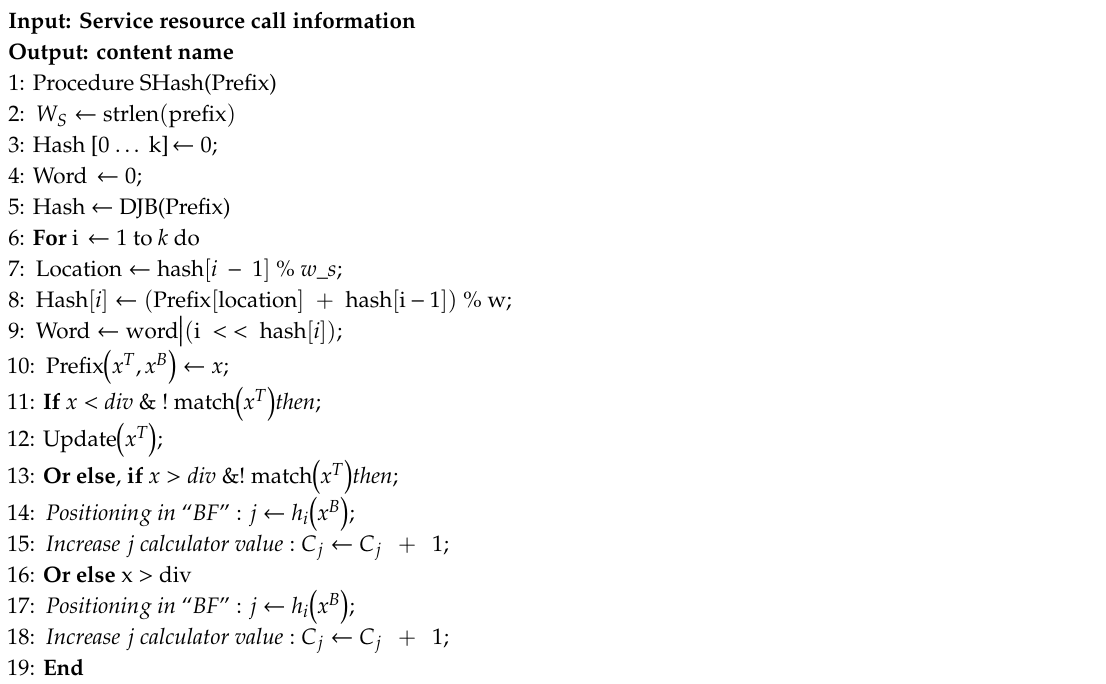
Algorithm 1. Flow of hybrid naming